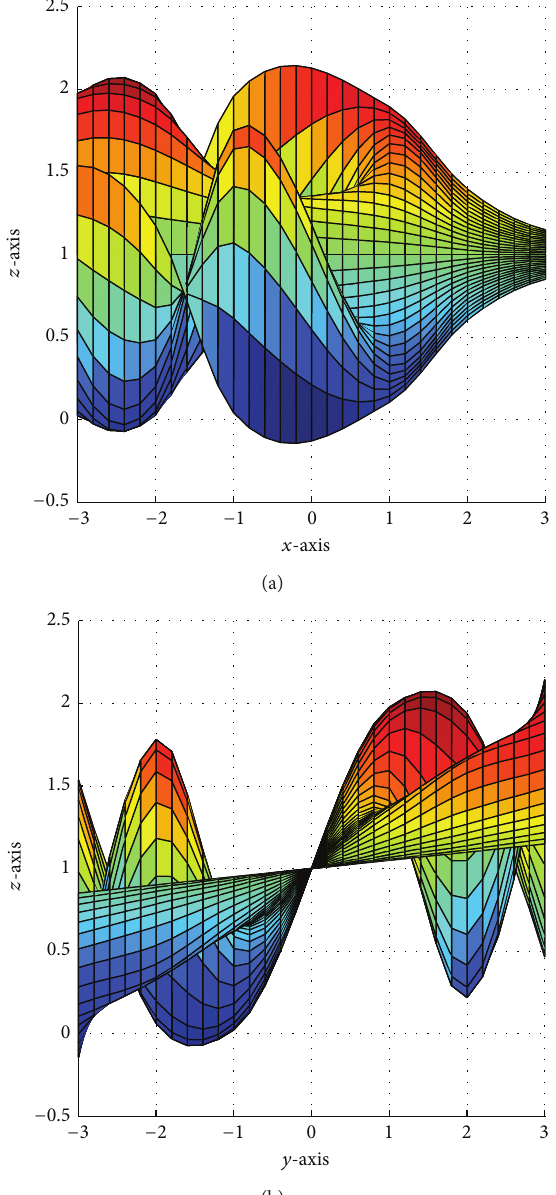
Figure 7: Bicubic Hermite surface: (a) 𝑥𝑧 -view and (b) 𝑦𝑧 -view for Figure 6,